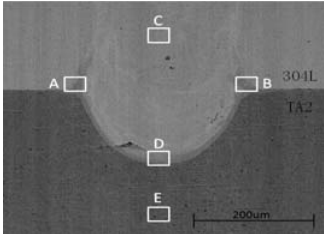
Figure 7. Scanning electron microscope (SEM) image of the welding joint of 304L stainless steel and TA2.